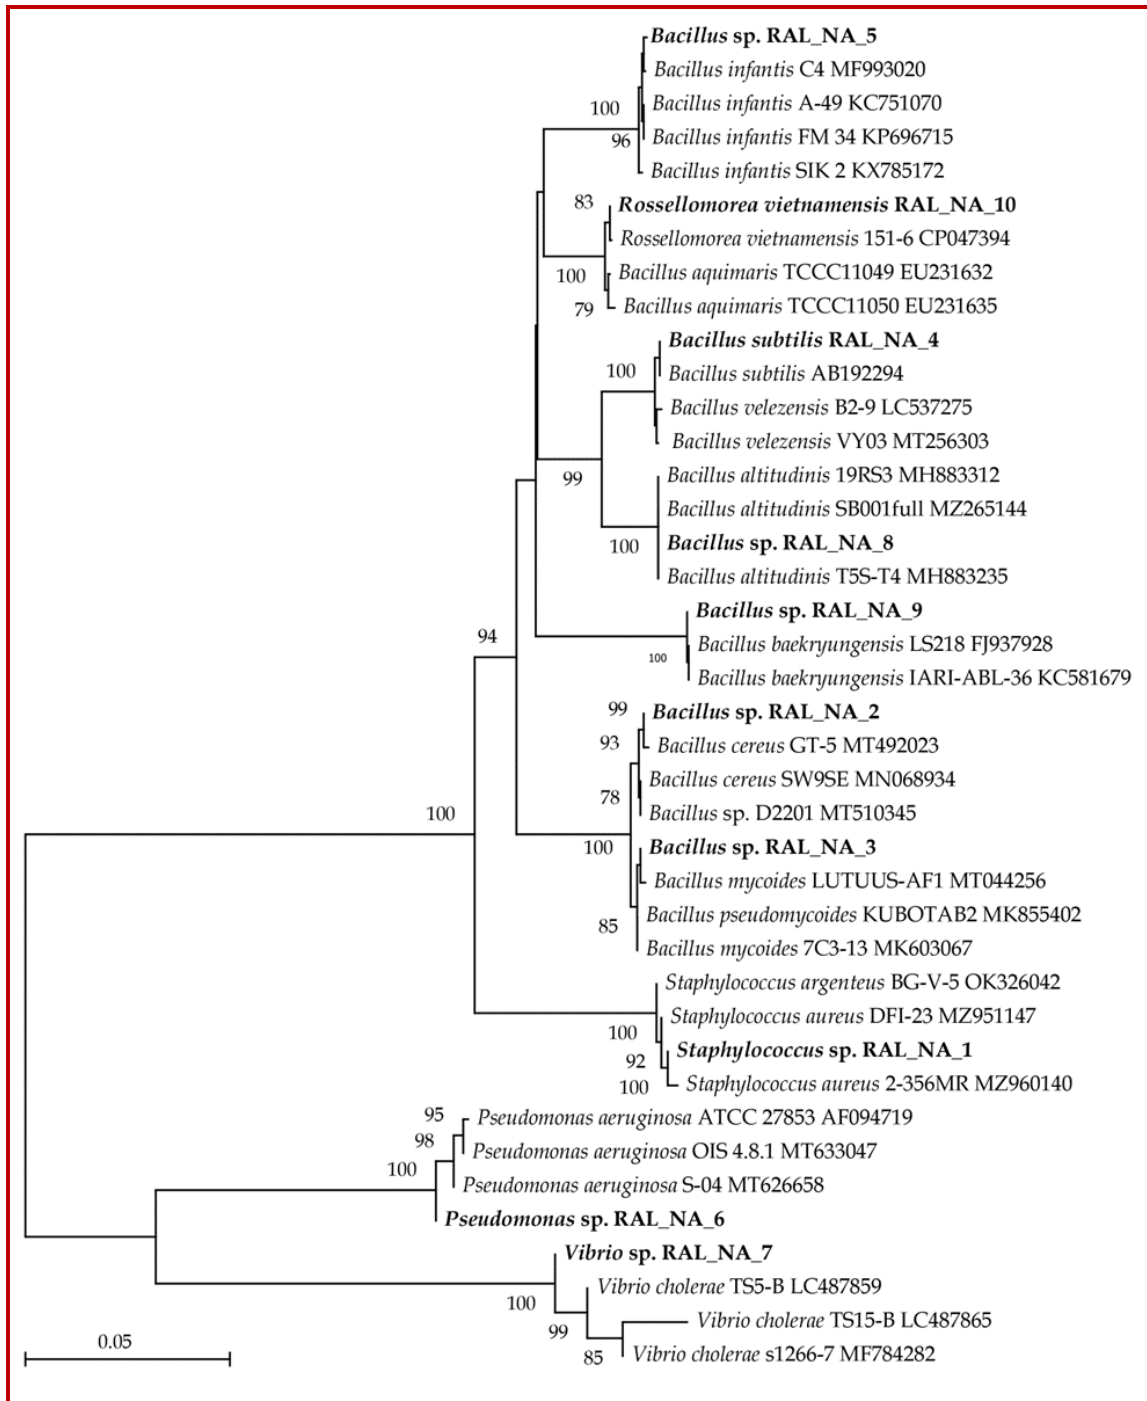
Figure S1: Phylogeny of 16S rRNA gene sequences of the endophytic bacteria from the present study (bold letters) and from NCBI GenBank. Bootstrap support values of branches greater than 75% are given above the corresponding